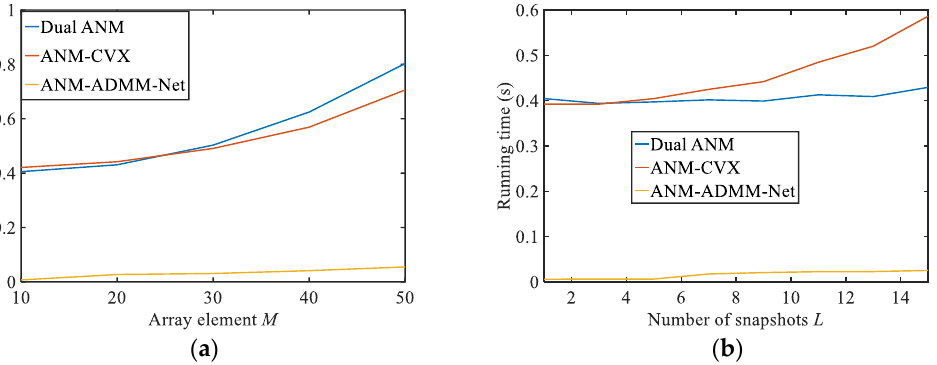
Figure 10. Running time versus array element number M and snapshot number L . ( a ) when M = 10 ∼ 50; ( b ) when L = 1 ∼ 15.